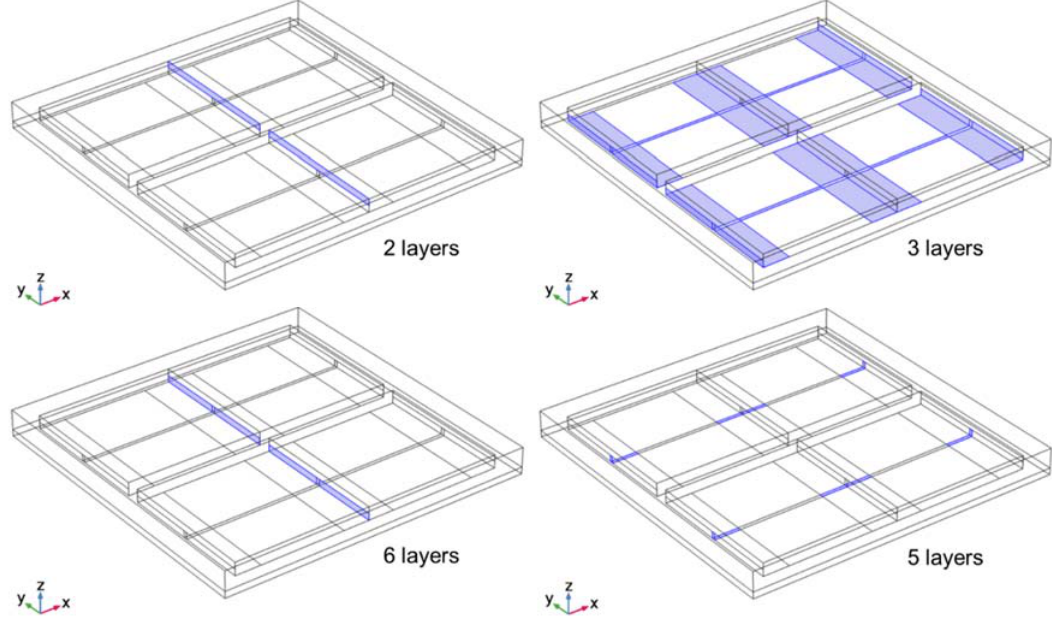
Figure 7. Highlighted barrier film flaps and joints between VIPs in composite ‘d’ model. The model dimensions are the same as composite ‘c’ shown in figure 6.